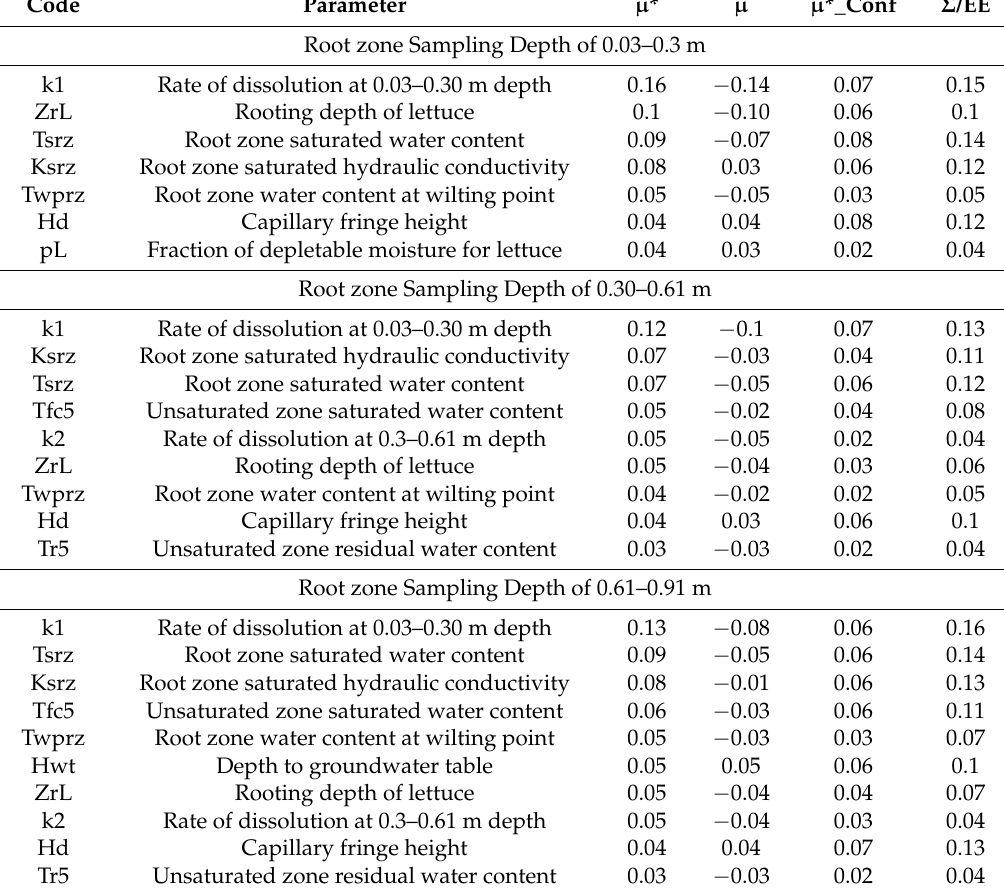
Table 5. Parameter sensitivity based on Morris